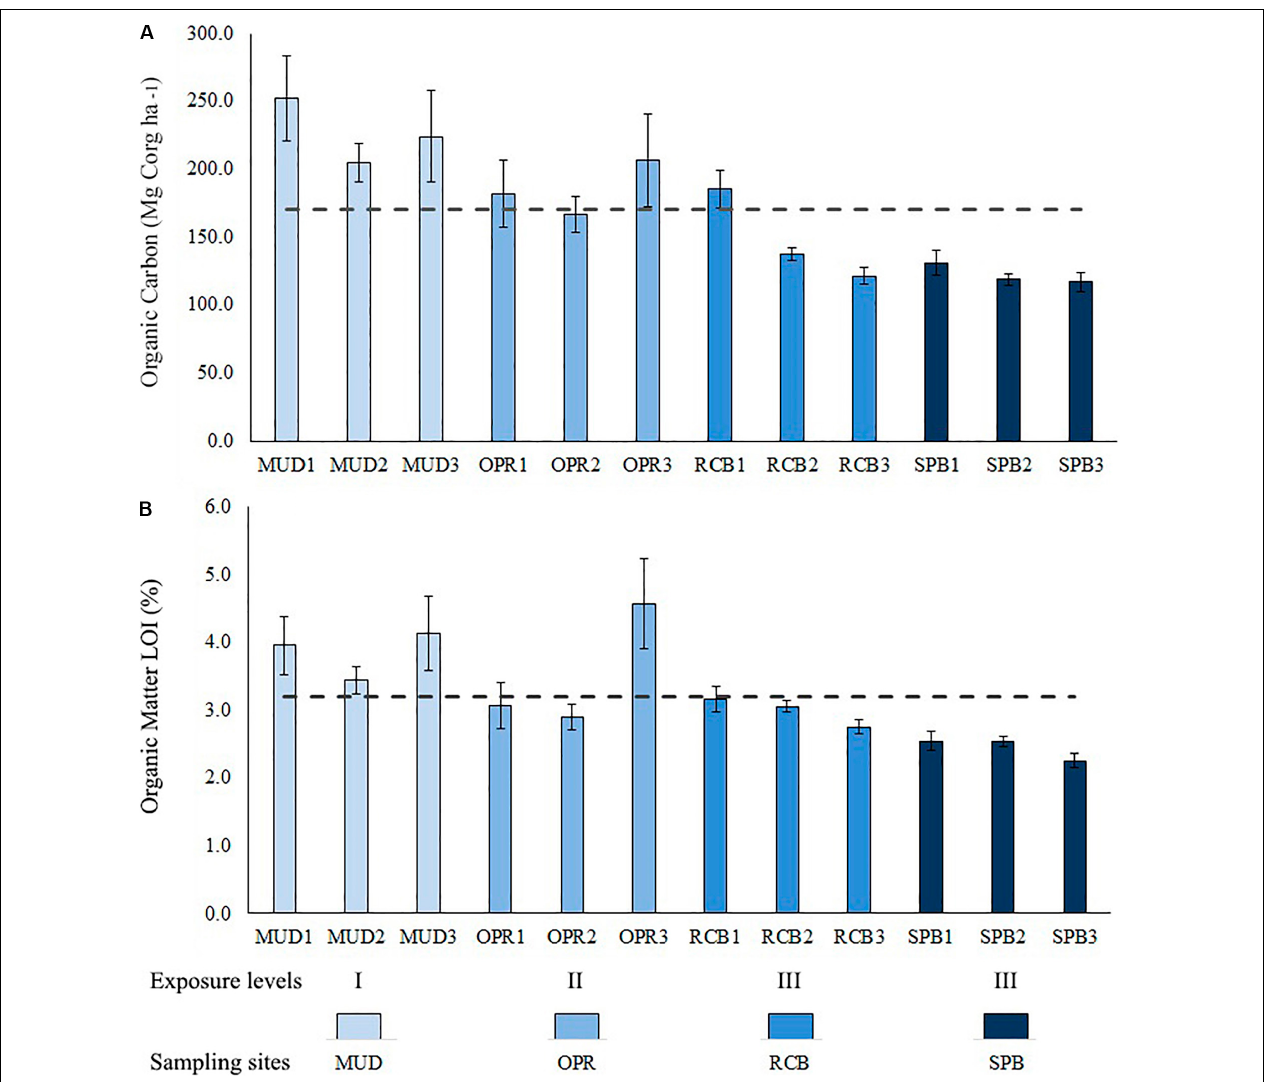
FIGURE 5 | Bar plot showing means ( ± SD) per depth stations (deep 1, mid 2 and shallow 3) per site (MUD, OPR, RCB, and SPB). (A) Sediment organic carbon (Mg Corg ha − 1 ). (B) Sediment organic matter (%) determined by LOI method. Means of study area are represented by the dashed lines. Exposure to waves levels is included (I, II and